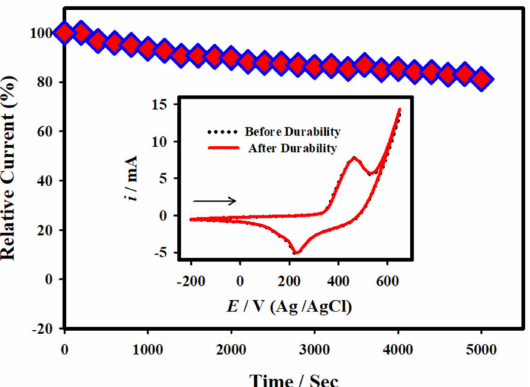
Figure 6. Plot of the relative anodic peak current of glucose oxidation against time at the 1.0 mM sensing electrode in 10.0 mM glucose + 1.0 M KOH ( E app : 0.5 V). Inset: CV curves of NC-NiS@NS- NiS|NF before (dotted curve) and after (solid curve) had a stability in 10.0 mM glucose + 1.0 M KOH at a scan rate of 20.0 mVs − 1 .